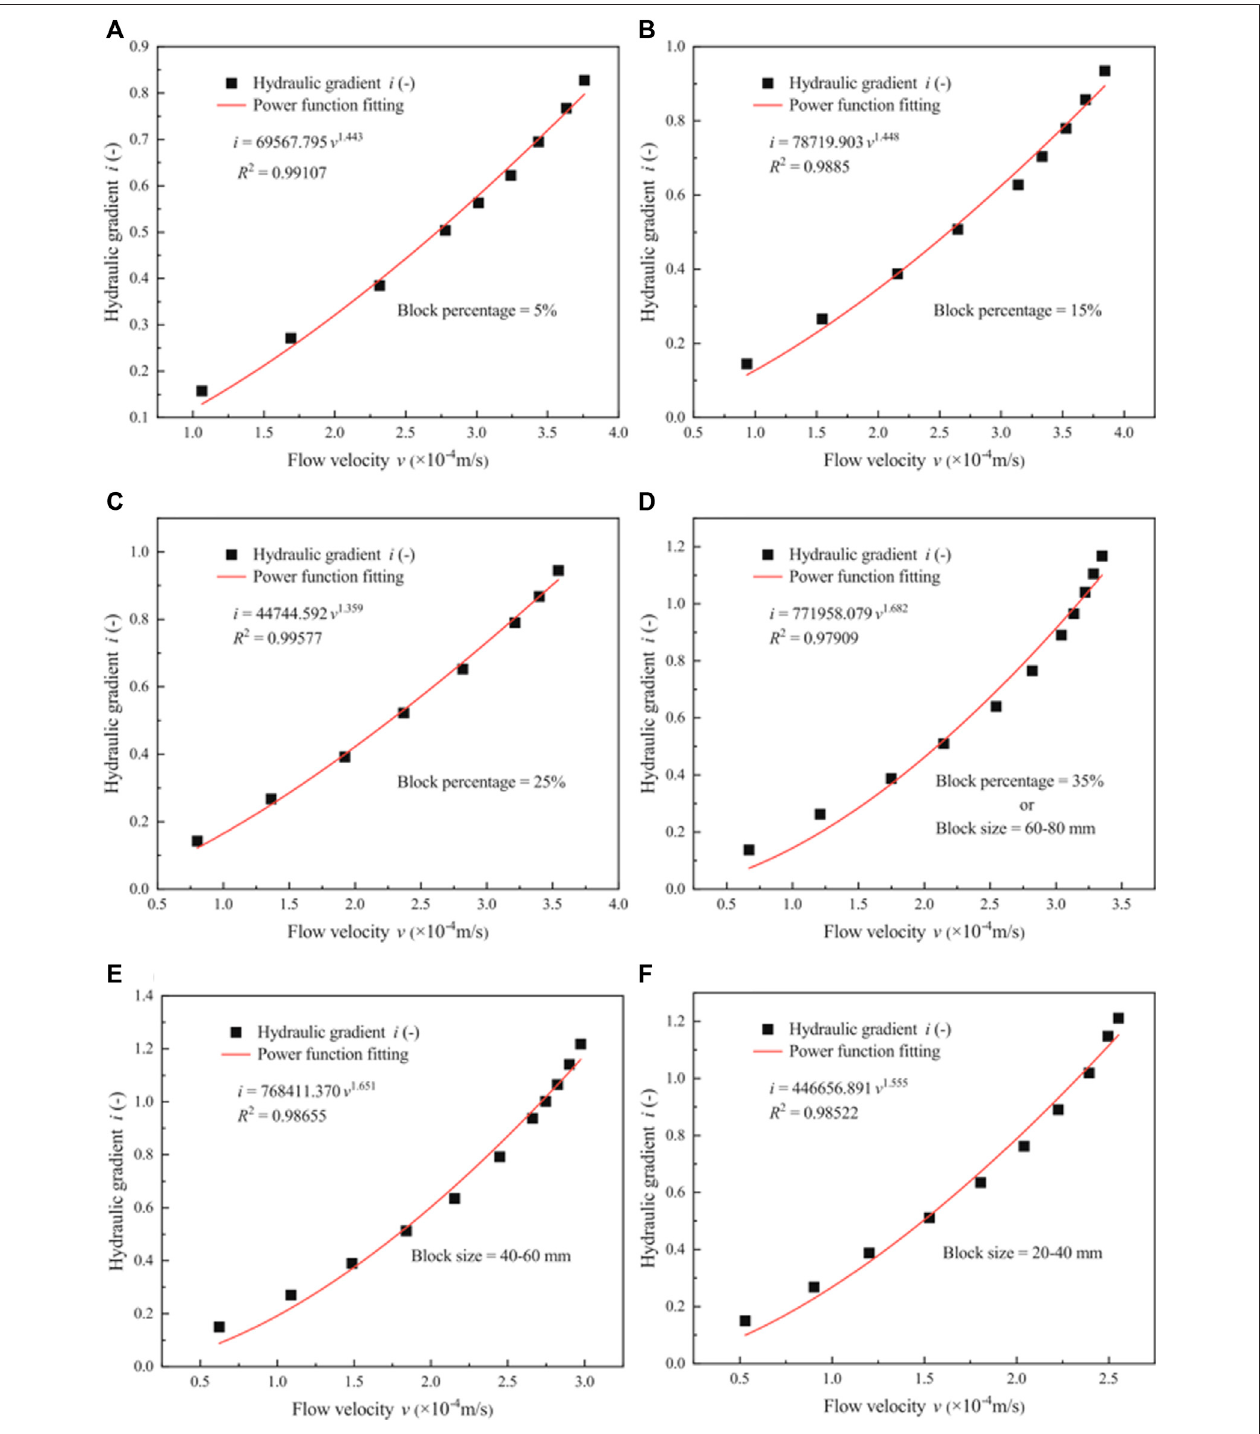
FIGURE 10 | Relationship between the hydraulic gradient and the fl ow velocity by Izbash equation. (A – D) Plots for phyllite bimrocks with different block percentages of 5%, 15%, 25%, and 35%, respectively; (D – F) Plots for phyllite bimrocks with different block sizes of 60 – 80, 40 – 60, and 20 – 40 mm, respectively.